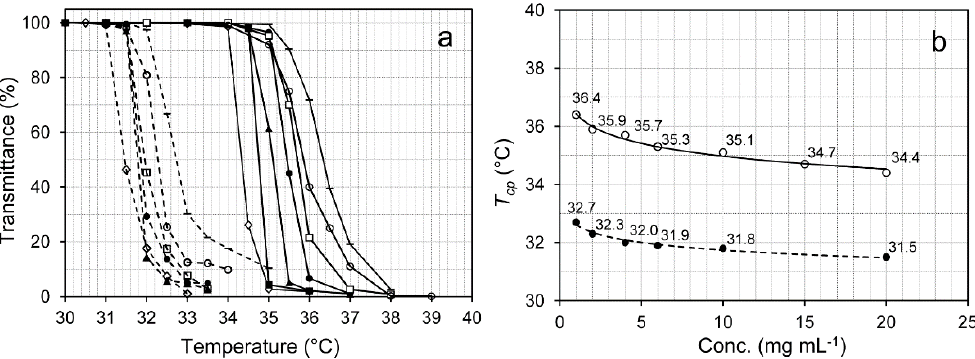
Figure 13. Tcp for poly(OEGMA-co-DEGMA) with 24% of mol fraction of OEGMA at different concentrations ( a ) Transmittance curves at (◊) 20, ( ■ ) 15, ( ▲ )10, (●) 6, (□) 4, ( ○ ) 2, and ( ) 1 mg mL −1 using water as solvent (solid lines) or phosphate buffered saline pH = 6.8 (dashed lines); ( b ) Tcp measured by transmittance as a function of the copolymer concentration using ( ○ ) distilled water or (●) PBS pH = 6.8.